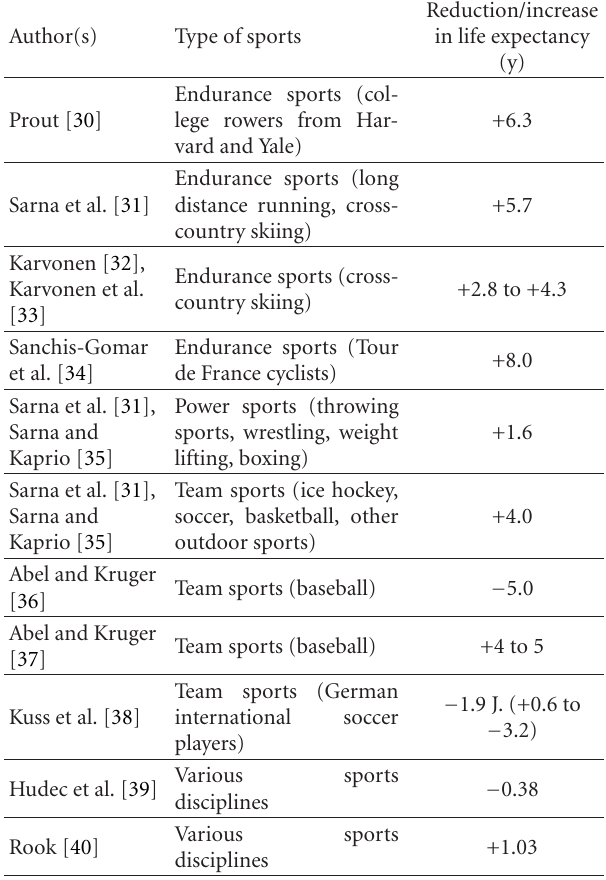
Table 4: Case control studies presenting life expectancy of (former) athletes compared to that of control